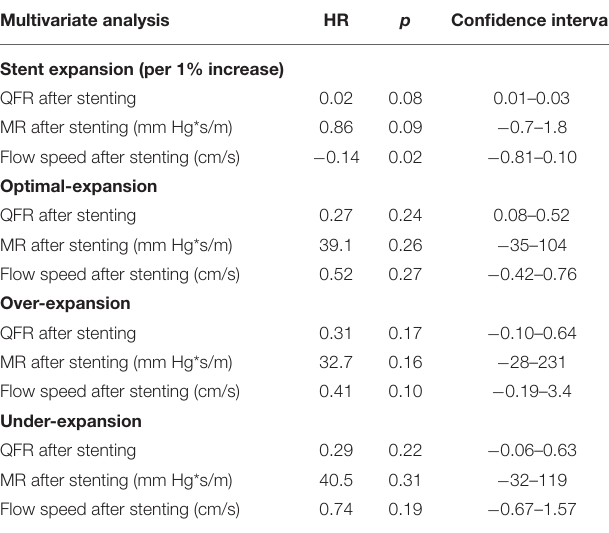
TABLE 4 | Multivariate analyses of stent expansion of QFR. Multivariate analysis Confidence interval